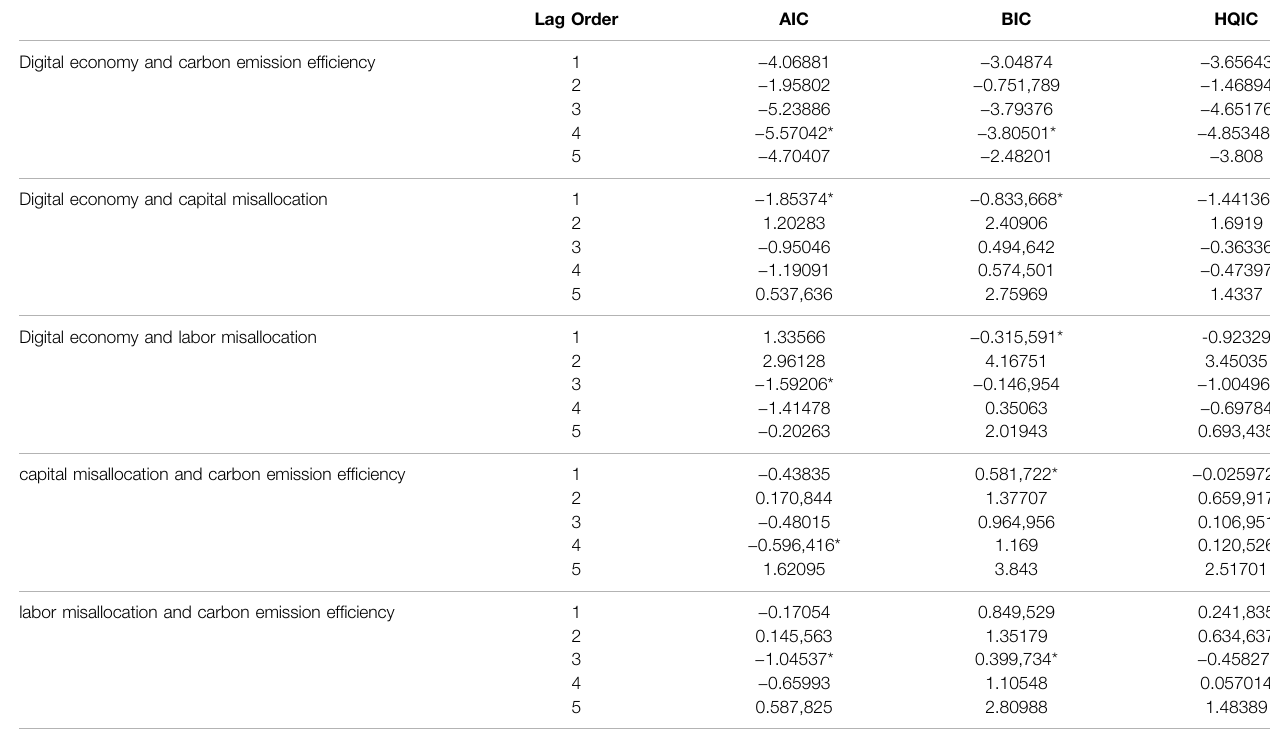
TABLE 10 | Lag order test result.